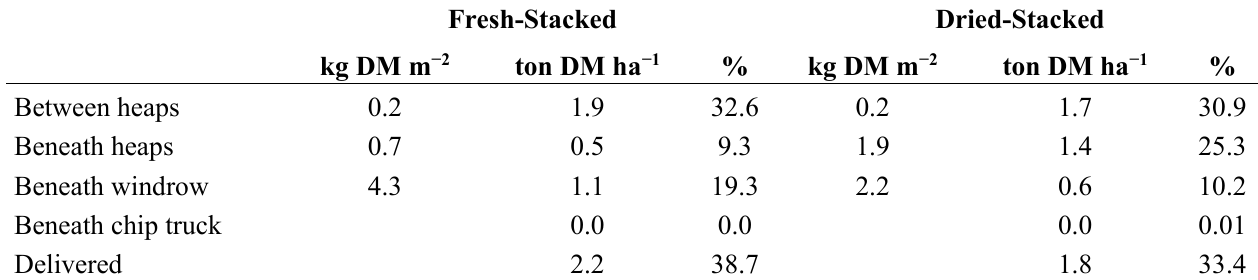
Table 3. The estimated distribution of % needles on the clear-felled area using the two handling methods. The results are also shown in kg DM m −2 and ton DM ha −1